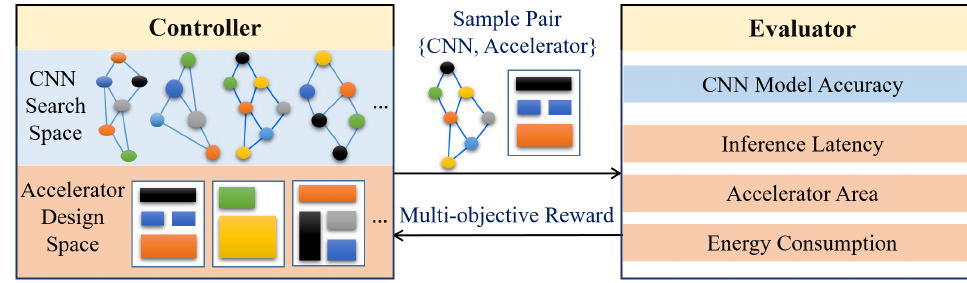
Figure 9. Analogy of the NAS-based co-design of an efficient CNN–accelerator